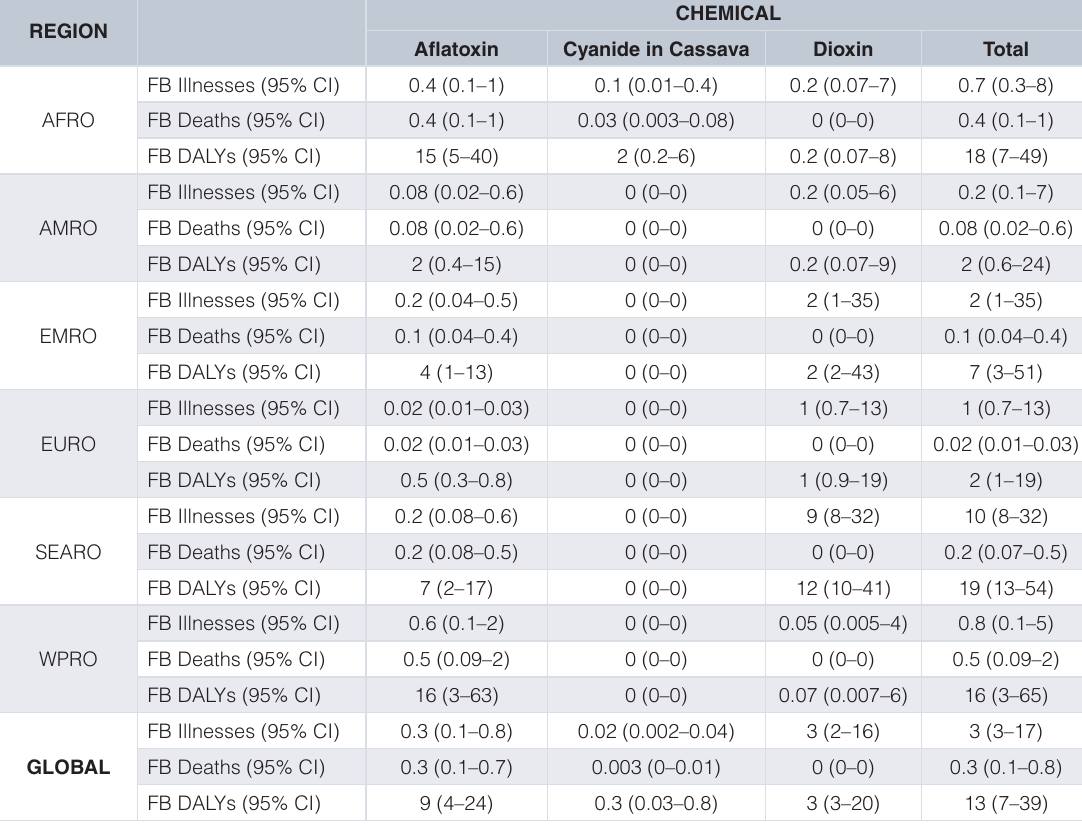
contrasts the proportion of DALYs due to YLL and YLD for each of the four chemicals. Virtually all of the DALYs for aflatoxin and most of the DALYs for cyanide in cassava are due to YLL, whereas most of the DALYs for peanut allergen and all of the DALYs for dioxin are due to YLD. Figure 3 shows the uncertainty around the DALY estimates for each of the four chemicals. The chemical with the least uncertainty and the most number of DALYs is